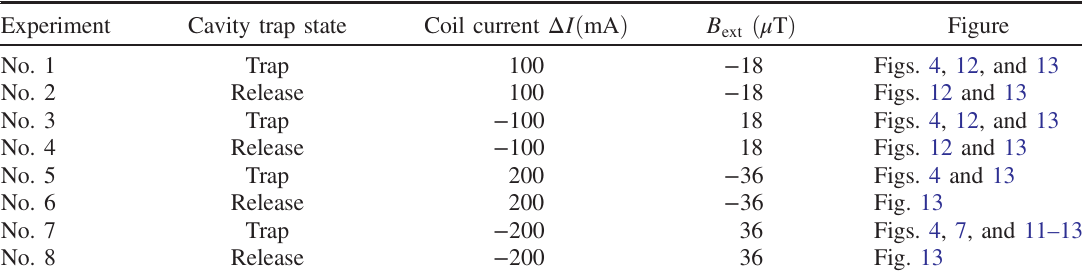
TABLE I. Table of experiment conditions. Columns are experiment number, cavity state, coil current, applied magnetic flux density, and figure number. Experiment